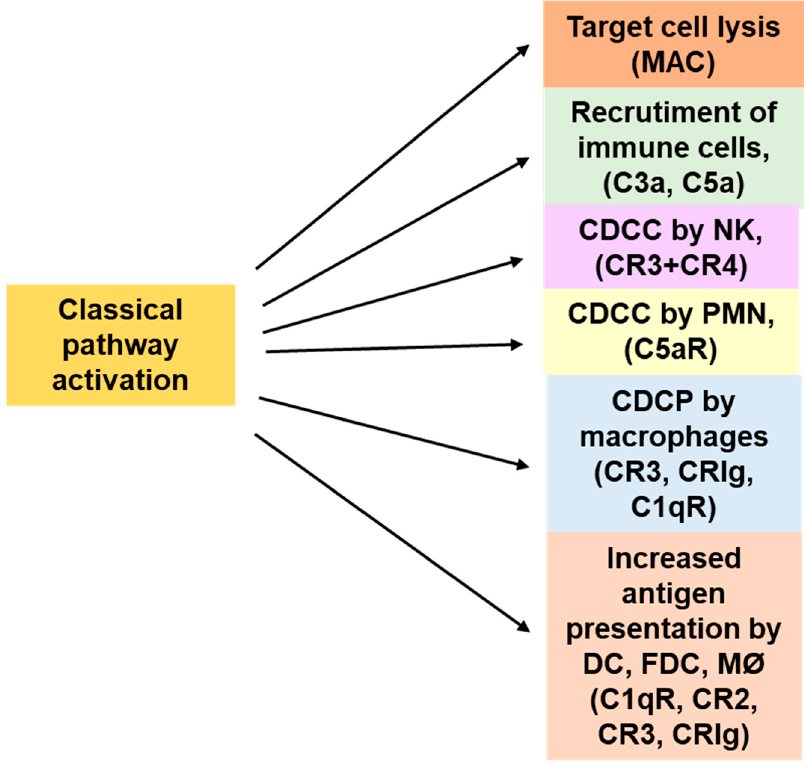
Figure 2. Multiple possible roles of complement for tumor control by IgG1 MAbs. Complement activation leads to complement mediated cell lysis but also to recruitment and activation of immune cells through complement fragments and their receptors which amplify the Fc-mediated ADCC and ADCP of IgG1 antibodies. CDCC: Complement dependent cellular cytotoxicity; CDCP: Complement dependent cellular phagocytosis; DC: dendritic cell; FDC: Follicular dendritic cells, MAC: membrane attack complex. MØ: macrophages; PMN: polymorphonuclear neutrophil; C1qR: C1q receptor, CR2, CR3, CR4, and CRIg: Receptors for complement fragments.